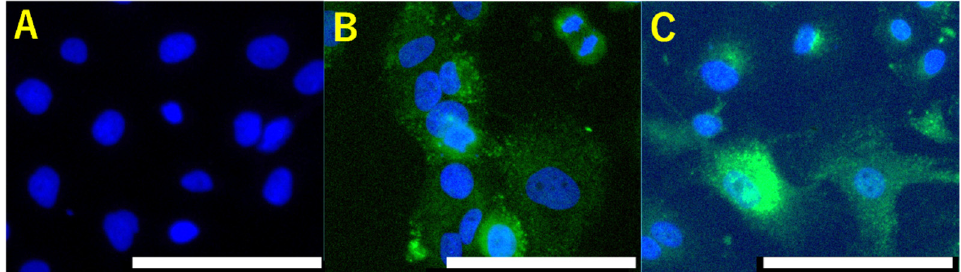
Figure 2. Abundant retinol dehydrogenase 10 (RDH10) expression in ovarian clear cell carcinomas. In contrast to SK-OV-3, ovarian serous cell carcinoma ( A ), ovarian clear cell carcinoma cells, OVISE ( B ), and TOV-21 ( C ) express high levels of retinol dehydrogenase 10 (RDH10). Scale bars: 100 μ m.